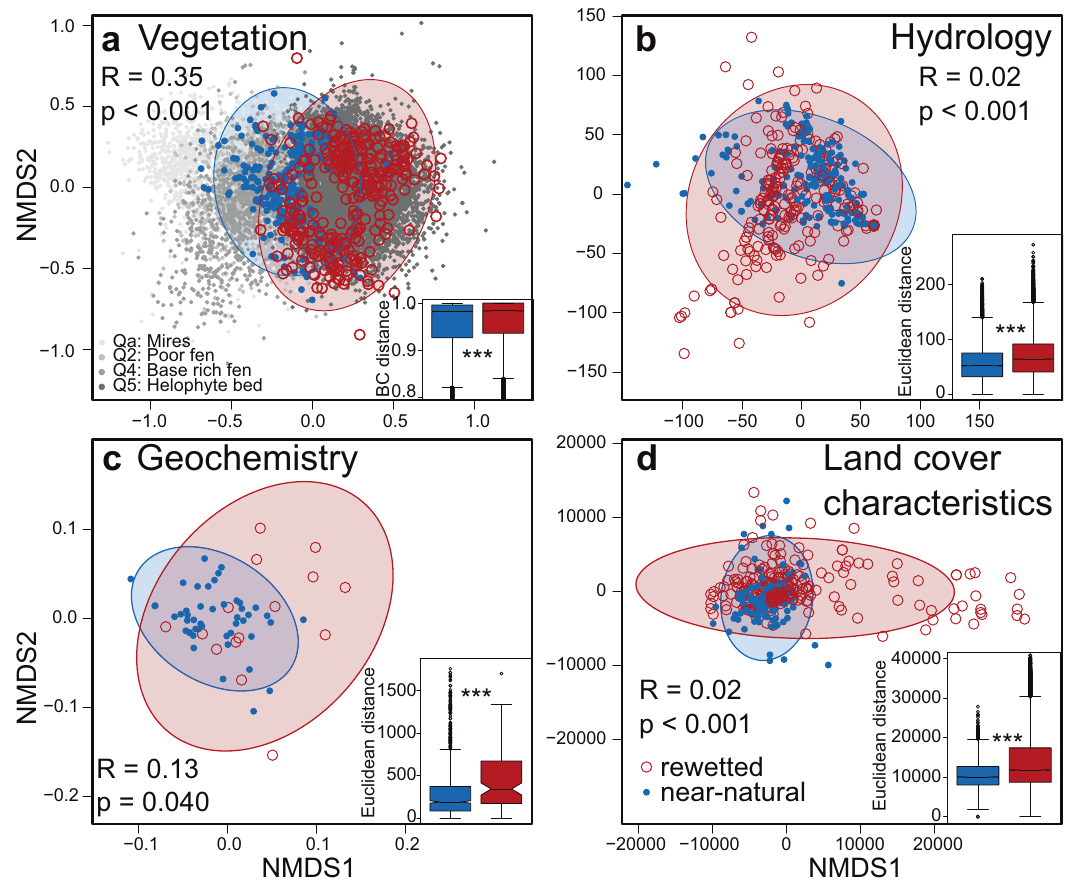
Fig. 2 Rewetted temperate fen peatland sites (open red) are more variable than near-natural sites ( fi lled blue) and many rewetted sites are outside the near-natural range of variation. Ordination (Non-metrical multidimensional scaling; NMDS) and analysis of similarity (ANOSIM) with its respective R value and p value provided in the fi gures. Dissimilarity is measured as Bray – Curtis distance for ( a ) vegetation based on 539 plant species ( n rewetted = 320, n near- = 243), and Euclidean distance for ( b ) hydrology (based on annual median water table, annual minimum water table, annual maximum water table, annual natural amplitude of water table; n rewetted = 320, n near-natural = 243), ( c ) geochemistry (based on pH of pore water, electrical conductivity of the pore water in the top soil layer, bulk density, organic matter content of the top layer; n rewetted = 16, n near-natural = 47) and ( d ) land cover characteristics measured as 208 spectral- temporal metrics of high resolution optical Earth Observation data ( n rewetted = 258, n near-natural = 114). The ellipses display 95%CI for each group. Sample size differs for the four response clusters according to data availability. The vegetation data are set into perspective against 10k vegetation plots randomly selected from>90k vegetation plots from Europe of the displayed EUNIS-classes 28 covering fen vegetation indicating the broad coverage of our near-natural sites. Note that no information about rewetting status is available for these background data. For vegetation, 63% of the rewetted sites are located outside the 95% con fi dence ellipse of the near-natural sites, for geochemistry 44%, for hydrology 20% and for spectral-temporal metrics 21%, respectively. Final stress of the two-dimensional ordinations are 0.16 for vegetation, 0.02 for hydrology, 0.04 for geochemistry, and 0.12 for land cover characteristics. The inserted boxplots display the median, quartiles (box), 1.5-fold quartile distance (whiskers) and extremes beyond the whiskers of all pairwise distances for rewetted sites in red and near-natural sites in blue ( a and b : n rewetted = 51040, n near-natural = 29403; c : n rewetted = 120, n near-natural = 1081; d : n rewetted = 33,135, n near-natural = 6441). Signi fi cance of difference in mean values between rewetted and near-natural was evaluated by a permutation procedure as described in the methods section (*** p <0.001 for all four